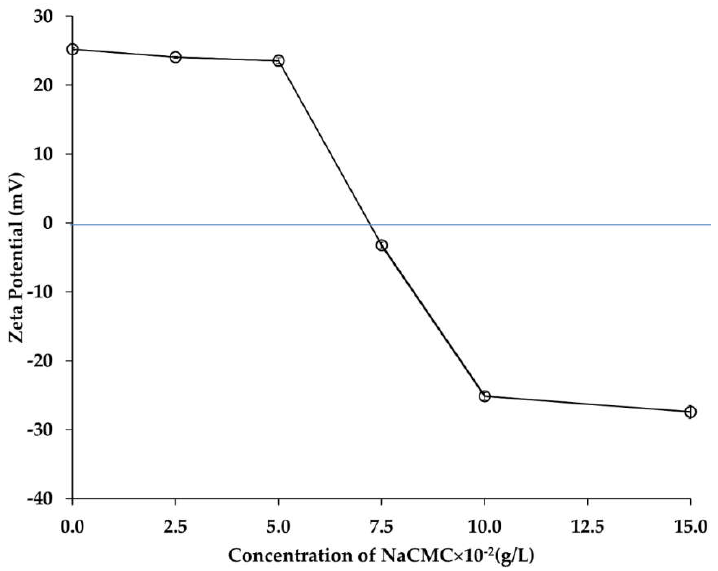
Figure 5. Zeta potential values after NaCMC layer formation in Emulsion‐2. The blue line indicated the neutral (charge balanced) zone of zeta potential. Mean values with 95% confidence interval.